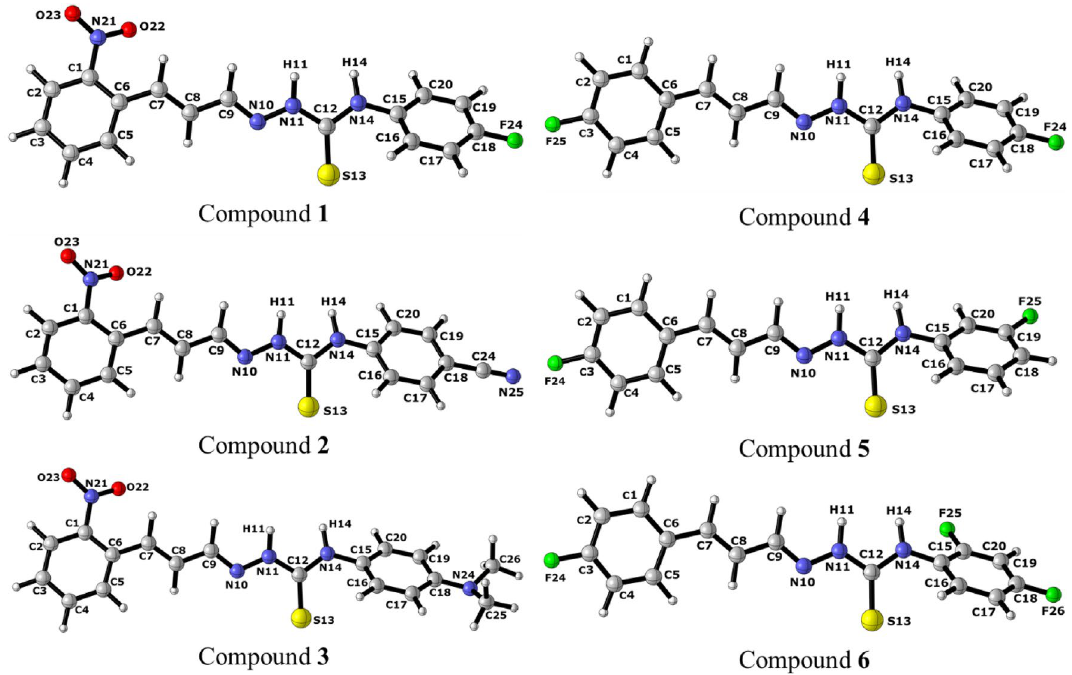
Figure 10. Scheme with the optimized geometries with B3LYP-D3/6–311 + (d,p)/SMD method of compounds 1 – 6 .